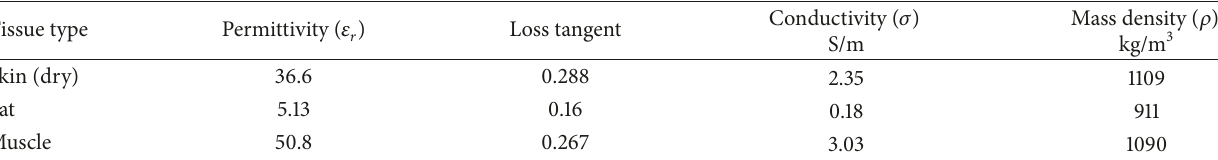
Table 1: Dielectric properties of human tissue at 5 GHz frequency.